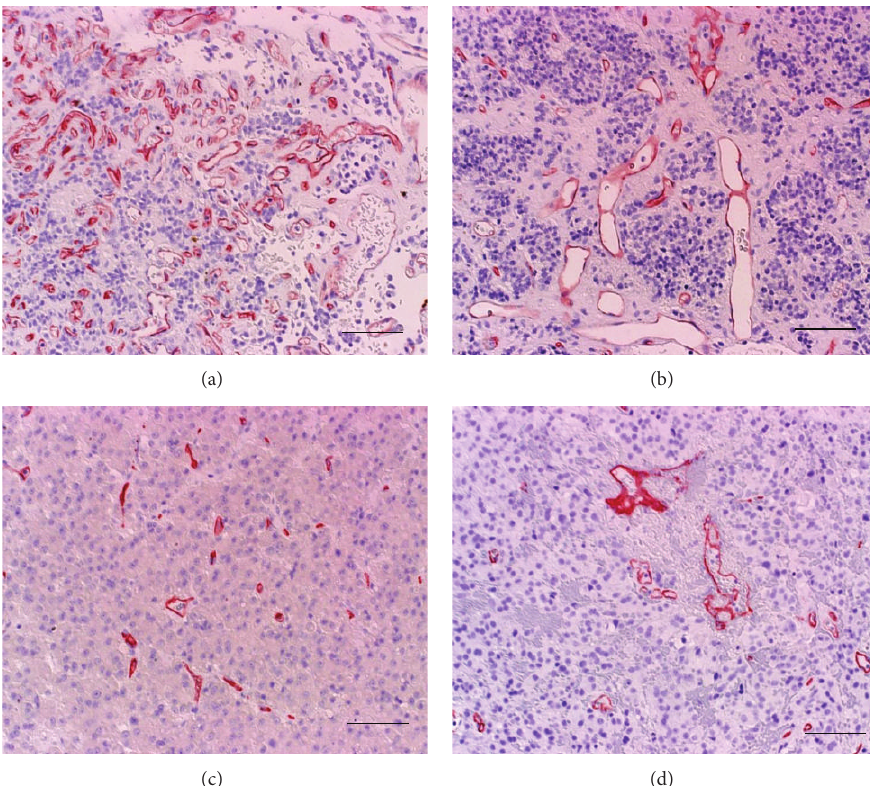
Figure 3: Representative vascular architecture (CD34 stain) of nonfunctioning (a), prolactin-secreting (b), GH-secreting (c), and ACTH- secreting (d) macroadenomas. Vessel diameter is larger in prolactin- and ACTH-secreting adenomas than nonfunctioning and GH-secreting adenomas. Vessel density and area are lower in ACTH-secreting adenoma than nonfunctioning and PRL-secreting adenomas. Original magnification: 200x. Bar 100 𝜇